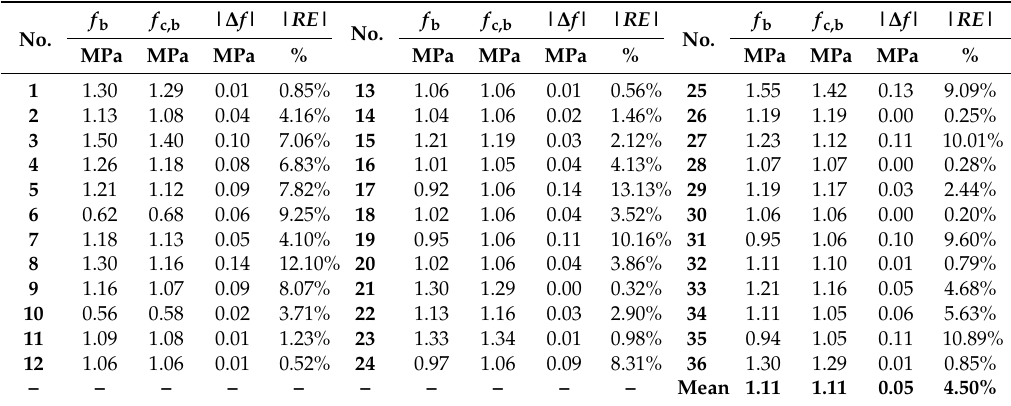
Table 8. Comparative summary of the values of f b and f c,b , defined using the pull-off method and ICA-ANN,